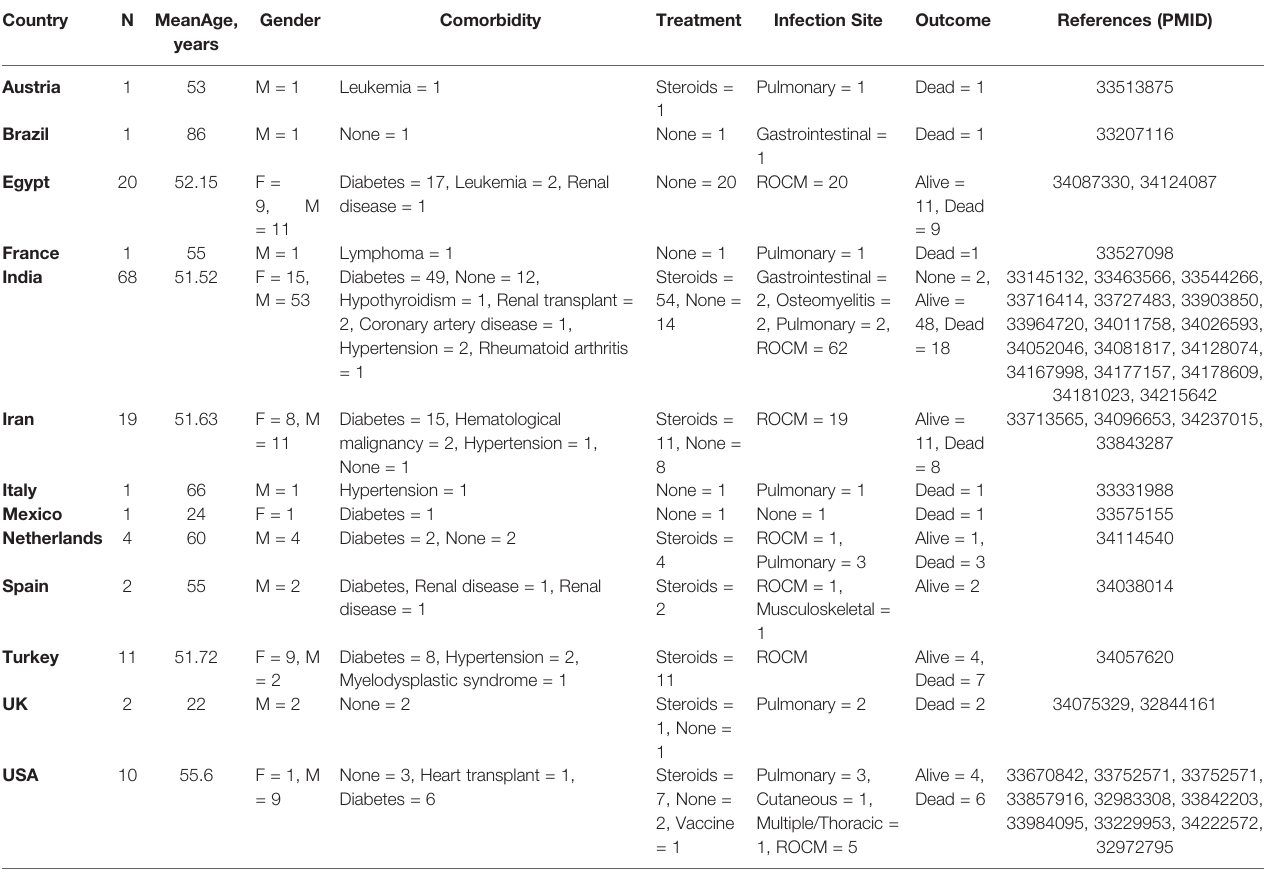
TABLE 1 | Worldwide reported cases of COVID-19-associated